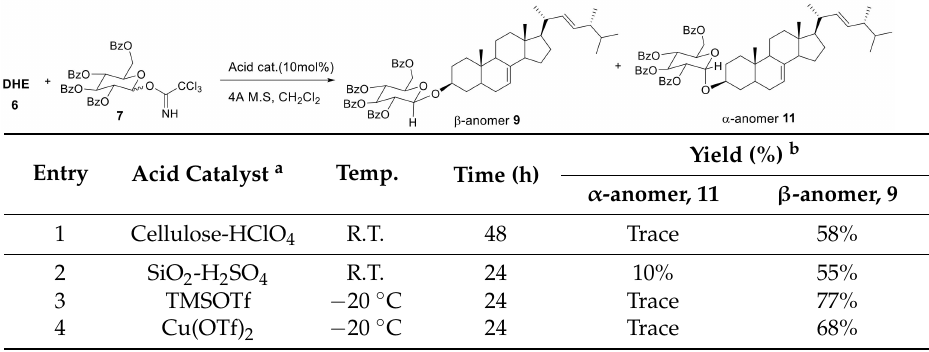
Table 1. Glycosylation of glucosyl imidate ( 7 ) with DHE ( 6 ) under various conditions a .